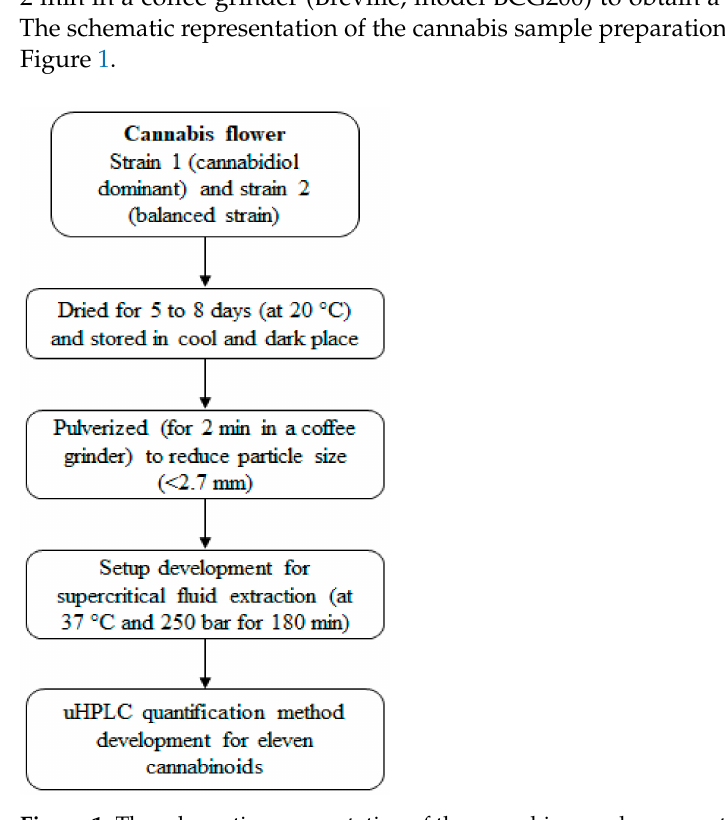
Figure 1. The schematic representation of the cannabis sample preparation and